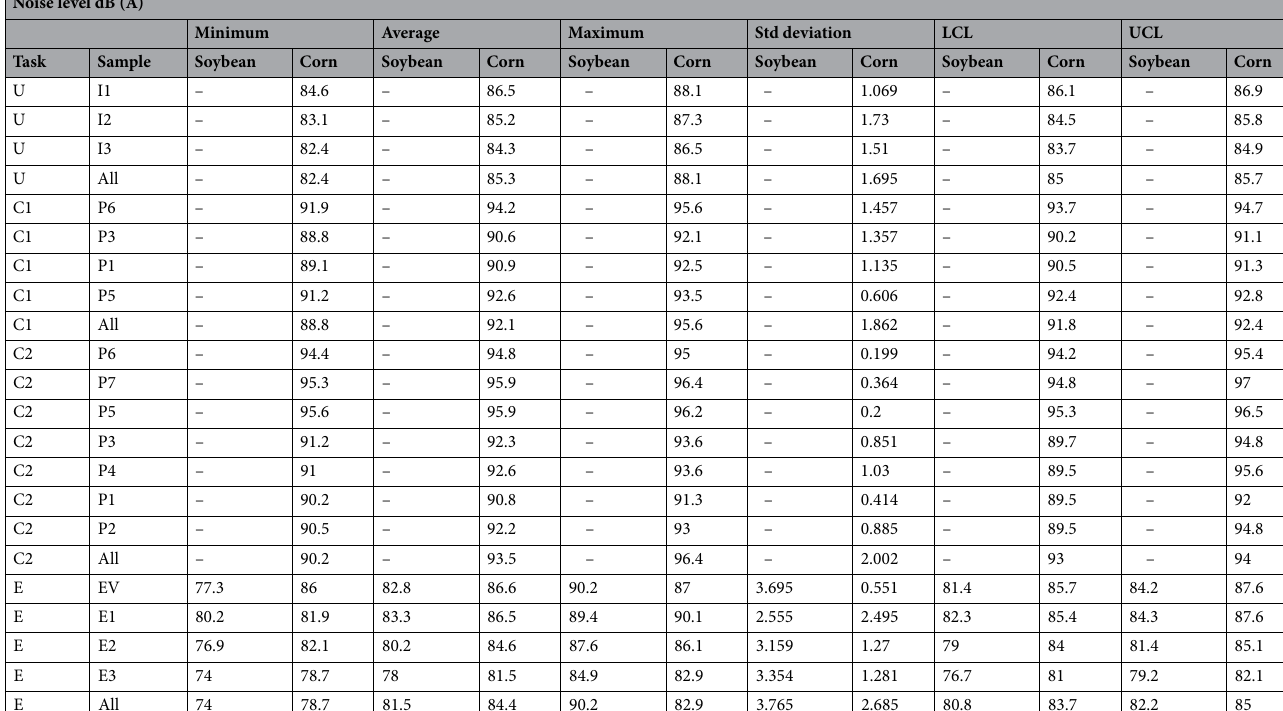
Table 3. Noise level measurement results at grain unloading (U), cleaning with one machine (C1) operation and two machines operation (C2), and expedition (E) postharvest operations. Where: LCL = Lower Confidence Limit; UCL = Upper Confidence